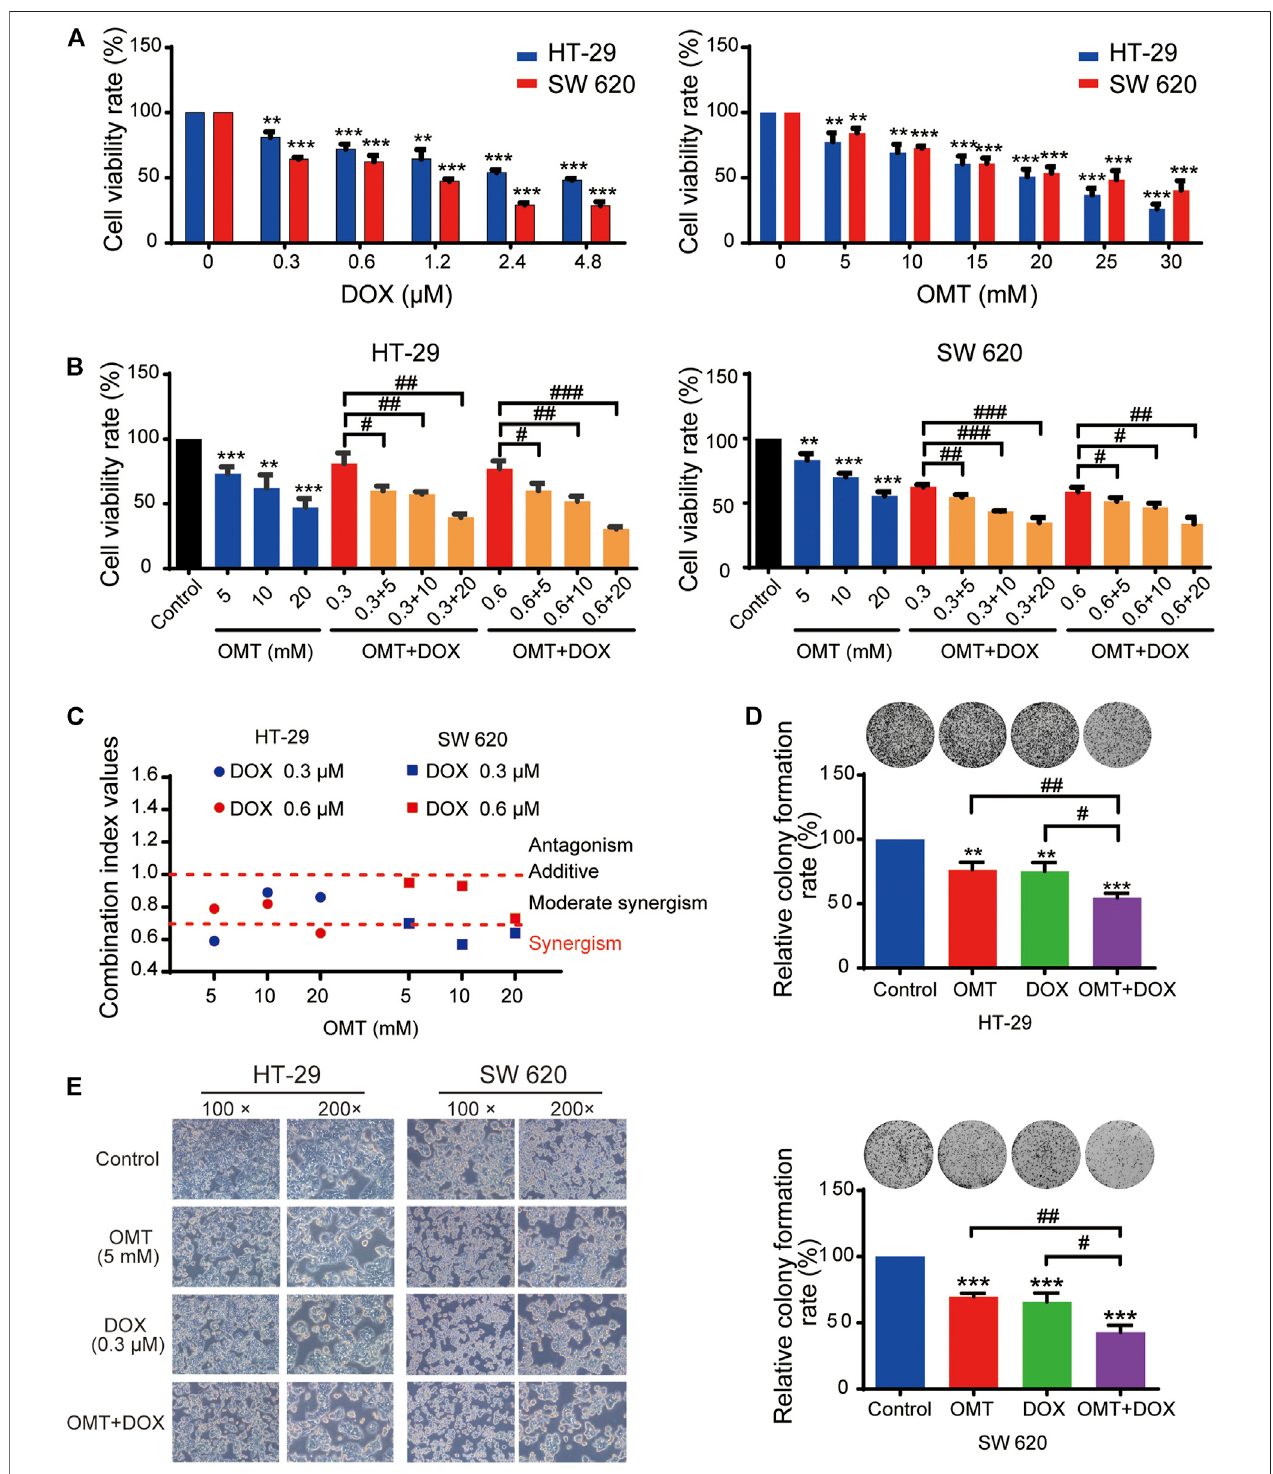
FIGURE 2 | OMT synergistically enhances the antiproliferative effects of DOX in CRC cells. (A) The MTT assay was used to measure the cell viability of HT-29 and SW620cellsundervariousconcentrationsofOMTorDOXtreatment. (B) HT-29andSW620cellsviabilityafterOMTand/orDOXtreatment. (C) Combinationindex(CI)of HT-29 and SW620cells afterOMT and/or DOXtreatment, CI < 1,synergistic activity; CI (cid:2) 1, additiveeffect;CI > 1,antagonism. (D) Representativeimages ofthe colony formationassayinHT-29andSW620cellsafterOMTorDOXtreatment (E) InvertedmicroscopywasusedtoobservethegrowthstatusofHT-29andSW620cells under OMT or DOX treatment. Data are presented as the mean ± SD of three independent experiments. ** p < 0.01, *** p < 0.001 vs. the control group; # p < 0.05, ## p < 0.01, ### p < 0.001 vs. the OMT (5 mM) group, DOX (0.3 μ M) group, or DOX (0.6 μ M) group.